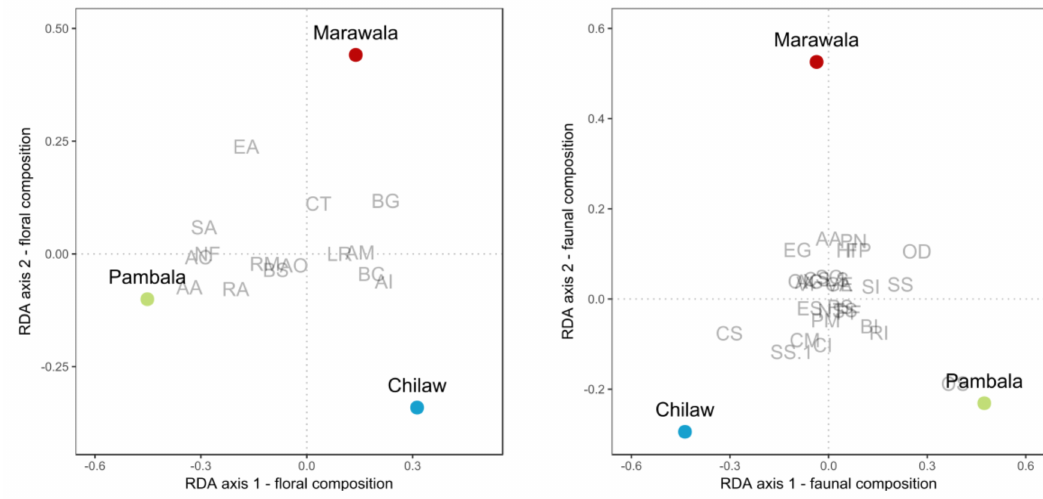
Figure 4. Results of separate constrained canonical ordinations based on the floral ( left ) and faunal ( right ) compositions in the surveyed transects of the three sites. Displayed are the first two ordination axes of which the first one was constrained to maximize the variation between the three sites (the points indicate the effects of the sites on the species composition are displayed. In the floral composition graph, we used the abbreviations in the parentheses to identify the species as Rhizophora mucronata (RM); Rhizophora apiculata (RA); Bruguiera cylindrical (BC); Bruguiera gymnorrhiza (BG); Bruguiera sexangula (BS); Ceriops tagal (CT); Avicennia officinalis (AO); Avicennia marina (AM); Lumnitzera racemosa (LR); Aegiceras corniculatum (AC); Nypa fruticans (NF) ; Acrostichum aureum (AA); Sonneratia alba (SA); Excoecaria agallocha (EA); Acanthus illicifolius (AI) and in the faunal composition graph we used the abbreviations in parentheses to identify the species as Egretta garzetta (EG); Ardeola grayii (AG); Phalacrocorax niger (PN); Alcedo atthis (AA); Corvus splendens (CS); Vanellus indicus (VI); Oriolus Xanthornus ceylonensis (OX); Funambulus palmarum (FP); Rhyothemis ingulate ingulate (RI); Brachythemis ingulatee (BI); Oecophylla smaragdina (OS); Odontomachus simillimus (OD); Scutiphora spec (SS); Tetragnatha spec (TS); Phimenes flavopictus (PF); Scylla ingula (SI); Chiromantes spec (CS); Neosarmatium spec (NS); Periophthalmus spec (PS); Littorina scabra (LS); Cassidula musterina